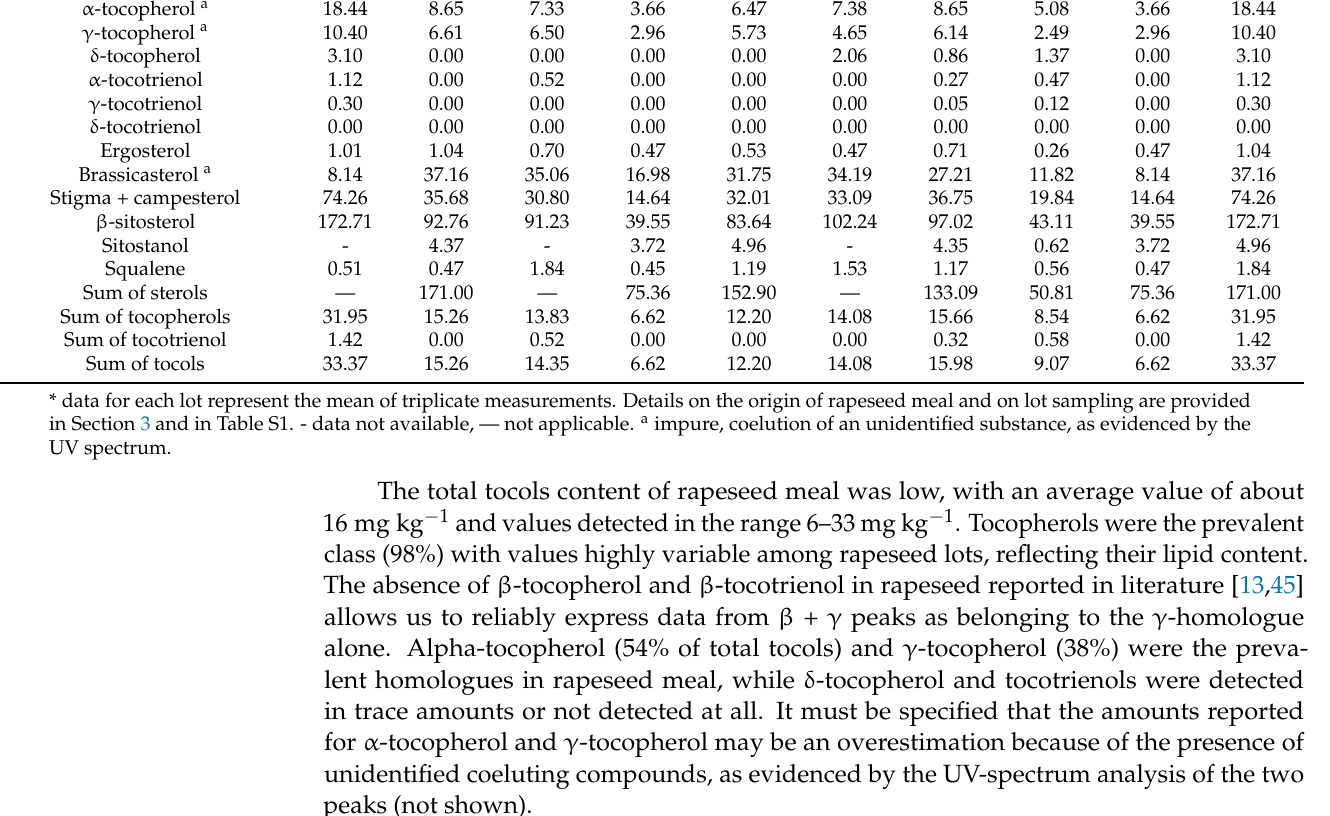
Table 5. Levels of tocopherols, tocotrienols, sterols and squalene in rapeseed meal samples. Mean, standard deviation, and range of values obtained from different lots collected between July 2018 and May 2019 ( n = 6) *.